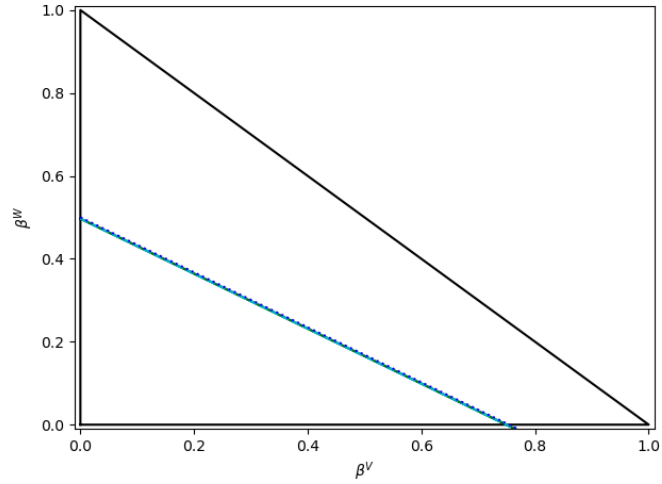
Figure 14. Boundaries for β V and β W as poposed by Okuno et al. [20] for water/n-octane mixtures. Notes: (i) reported lines are for 𝑅𝑅 𝑦 = 0 and 𝑅𝑅 𝑤 = 0 ; (ii) the two superimposed blue lines encom- pass both Equations (54) and (55) lines.